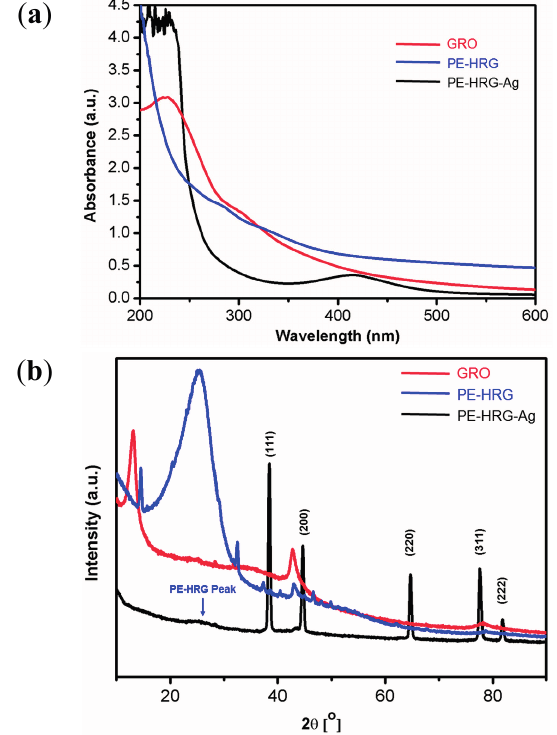
Figure 1. ( a ) Ultravoilet–visible (UV-Vis) absorption spectra of graphene oxide